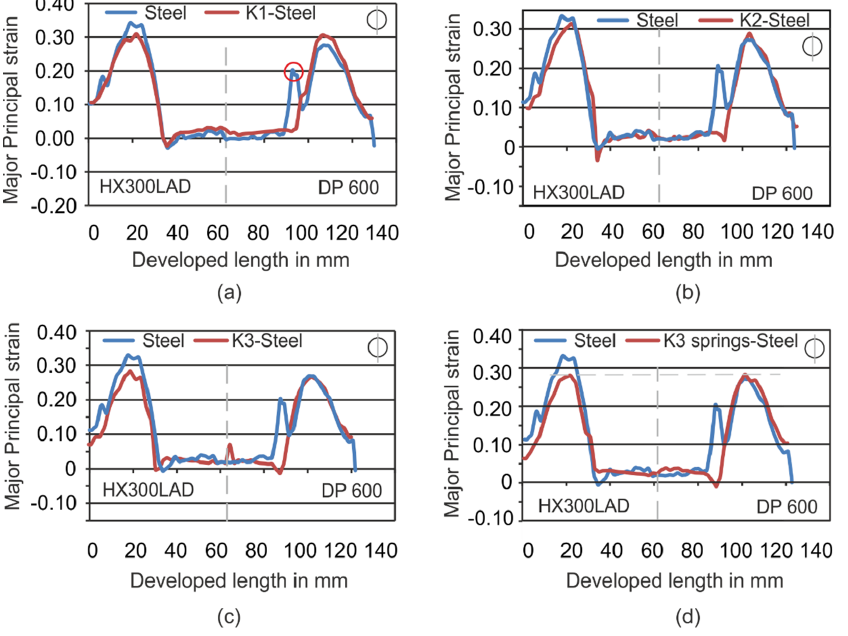
Figure 7. Comparison of major strains of Setup 1 with Setup 2 ( a ), Setup 3 ( b ), Setup 4 ( c ) and Setup 6 ( d ).